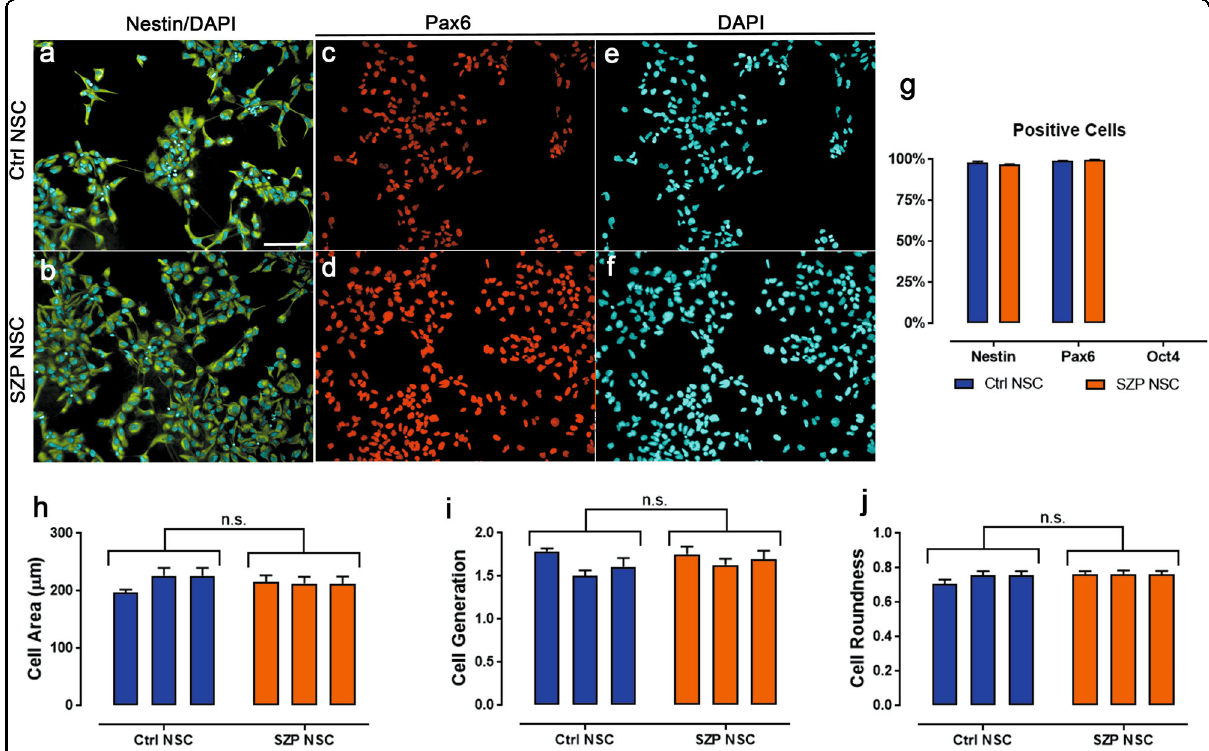
Fig. 1 Pro fi ling of NSC derived hiPSC obtained from Ctrl and SZP. Immunostaining for Ctrl ( a , c , and e ) and SZP ( b , d , and f ) NSC speci fi c markers; ( a and b ) Nestin (green) and nuclear marker DAPI (blue), ( c and d ) Pax6 (red) and corresponding nuclear marker DAPI ( e and f ); Scale bar = 100 um. Representative images from N = 3 (3 Ctrl NSC and 3 SZP NSC). g Percentage of positive cells, with 98% (±0.003) and 97% (±0.01) Nestin positive cells for Ctrl and SZP NSCs respectively; 99% (±0.002) and 99.7% (±0.002) Pax6 positive cells for Ctrl and SZP NSCs respectively. No Oct4 positive cells were detected in NSC of Ctrl and SZP. Data is shown as mean ± SD from N = 3. h Cell division was monitored for 12 h and no signi fi cant differences in proliferation were found between Ctrl and SZP NSC. Data for each cell line (Ctrl #1, #2, #3 and SZP #1, #2, #3) is shown in a correlative order control and graphed as mean ± SD. i , j Morphological parameters such as cell area ( i ) and cell roundness ( j ) did not show detectable differences among Ctrl and SZP groups. Data for each cell line (Ctrl #1, #2, #3 and SZP #1, #2, #3) is shown in a correlative order control and graphed as mean ±